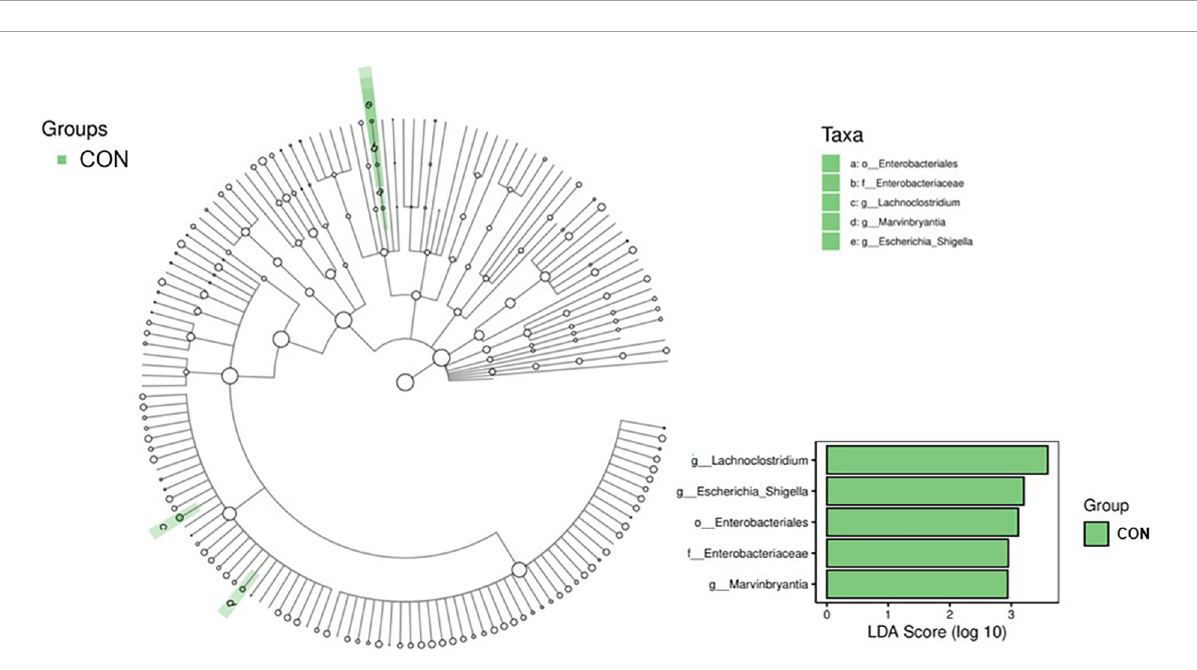
FIGURE3 Significantly changed bacteria between broilers in control group and RE750 revealed by LEfSe analysis. Only a linear discriminant analysis (LDA) score of > 2 was considered